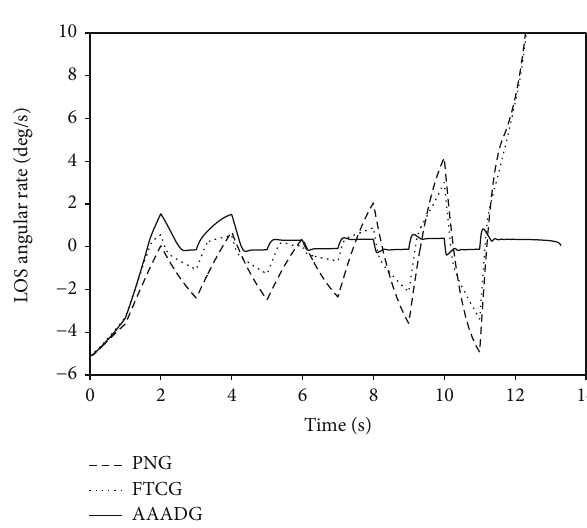
Figure 8: LOS angular rates under three guidance laws.